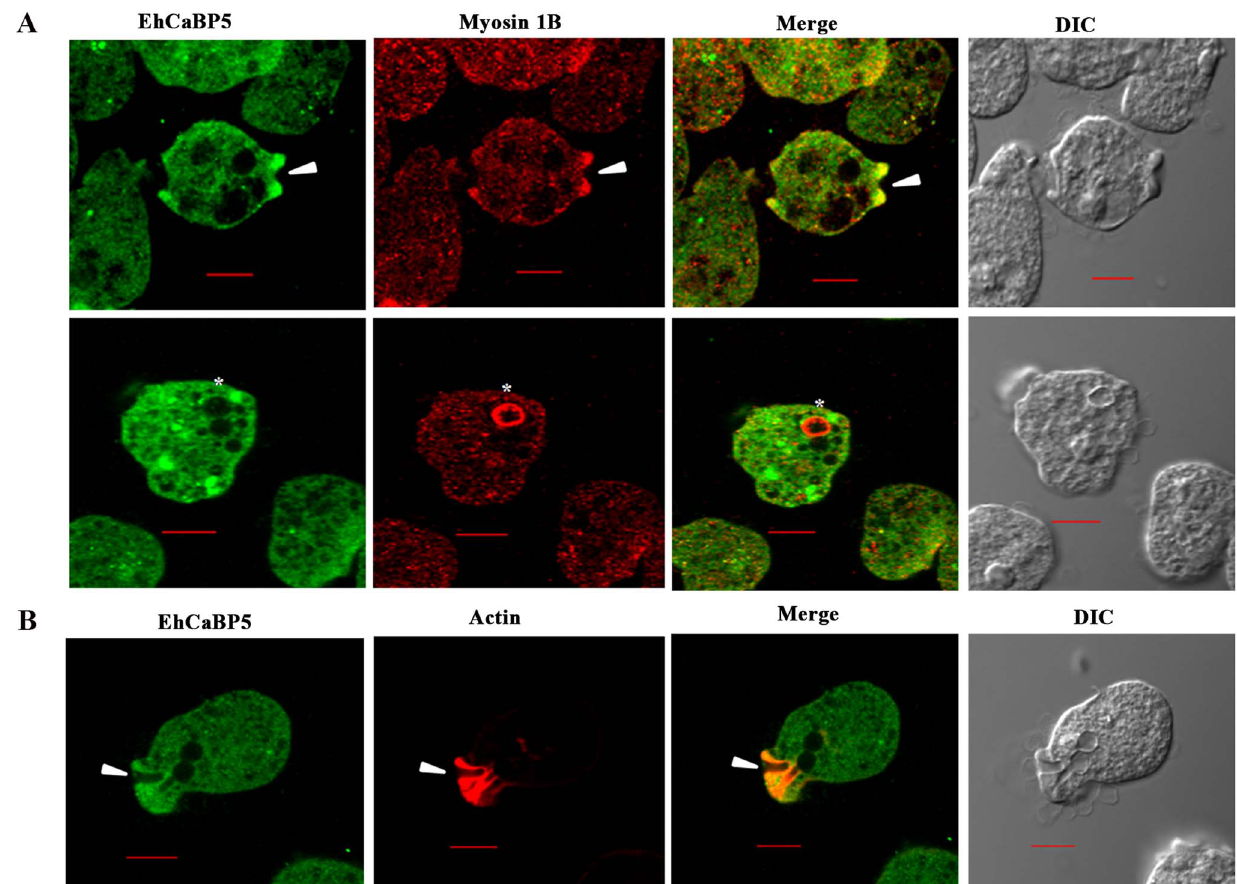
Fig 6. Distribution of EhCaBP5, myosin 1B and actin in E.histolytica during erythrophagocytosis. (A) Co- localization of EhCaBP5 and myosin 1B in E. histolytica cells during erythrophagocytosis. Cells were grown for 48 h and incubated with RBCs for 10 min at 37 u C. The cells were then fixed and immunostained with anti- EhCaBP5 and anti-myosin 1B antibodies followed by Alexa-488 (green) and Alexa-555 (red) secondary antibodies. Arrow head depicts the co- localization of CaBP5 and myosin 1B in the phagocytic cup (upper panel) and an asterisk mark shows the absence of EhCaBP5 in the phagosome. (B) Co-localization of EhCaBP5 with F-actin. Trophozoites were stained with anti-CaBP5 antibody and TRITC- phalloidin (red) was used to stain the F-actin. The secondary antibody used for EhCaBP5 was Alexa-488 (green). Bar represents 10 m m. (DIC, differential interference contrast).